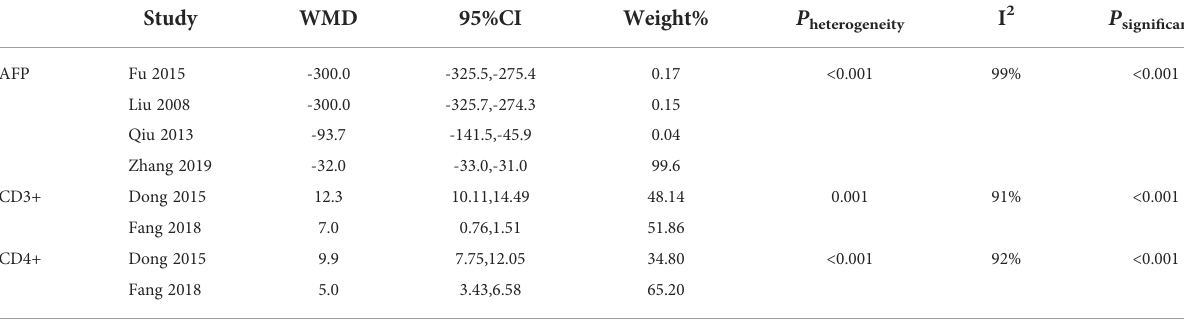
TABLE 3 Results of heterogeneity analysis of laboratory indicators.